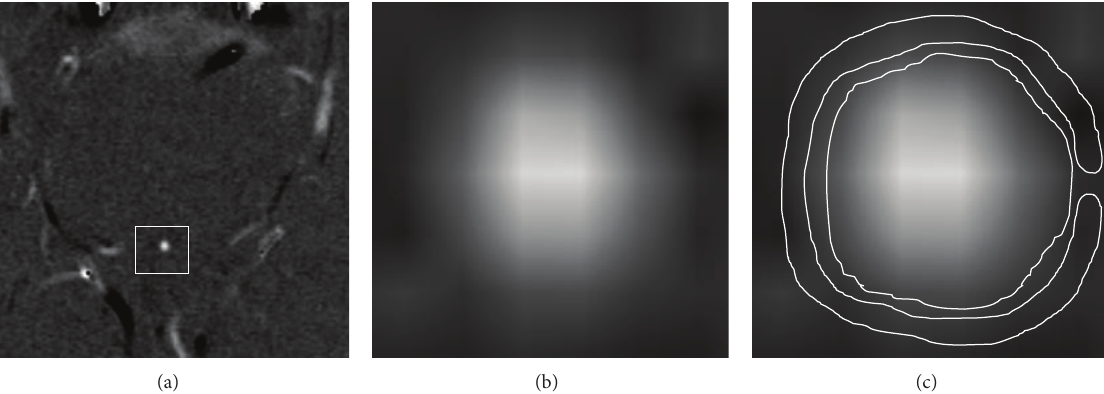
Figure 1: The original phase contrast imaging is shown in (a) and amplified in (b). The ROIs were placed manually to circulate through the whole aqueduct. The control reference of periaqueductal brain parenchymal matter is shown in (c) as a “C-shape” circulation area that avoided the basilar-vertebral vessel